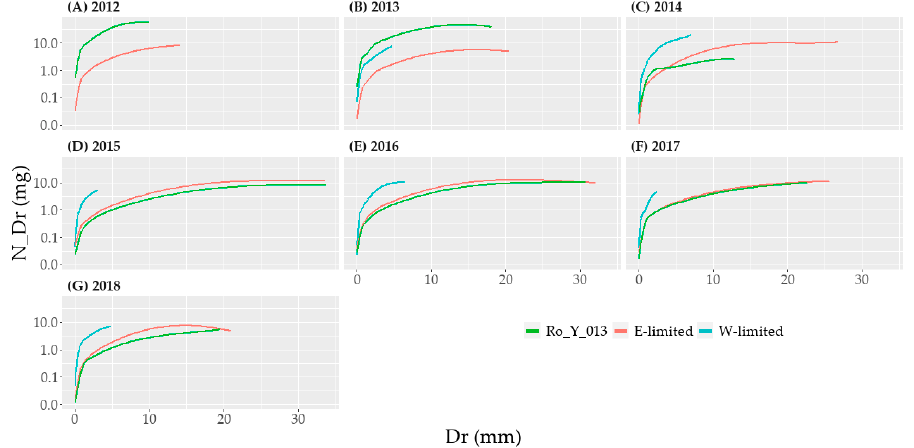
Figure 6. Interpolated relations of nitrogen mass in drainage (N_Dr) versus the amount of drainage (Dr) from the Rollesbroich lysimeters obtained from data pairs of the 14-days sampling periods between 2012 and 2018, for the lysimeters in Selhausen, the water-limited site (W-limited), the lysimeter Ro_Y_013 and the other lysimeters in Rollesbroich, the energy-limited site (E-limited). Because E-limited Ro_Y_013 behaved differently compared with the other E-limited lysimeters, its dataset is presented separately. The interpolation was done using a Locally Estimated Scatterplot Smoothing function with a span of 0.75. No observations of N_Dr were available for Selhausen in 2012.